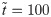
Test 1: Comparison between FOM and DL-ROM solutions for a testing-parameter instance.FOM solution (left), DL-ROM solution with n = 3 (center) and relative error ϵk (right) for the testing-parameter instance μtest = (6.25, 6.25) cm at t˜=100 ms (top) and t˜=356 ms (bottom). The maximum of the relative error ϵk is 10−3 and it is associated to the diseased tissue.